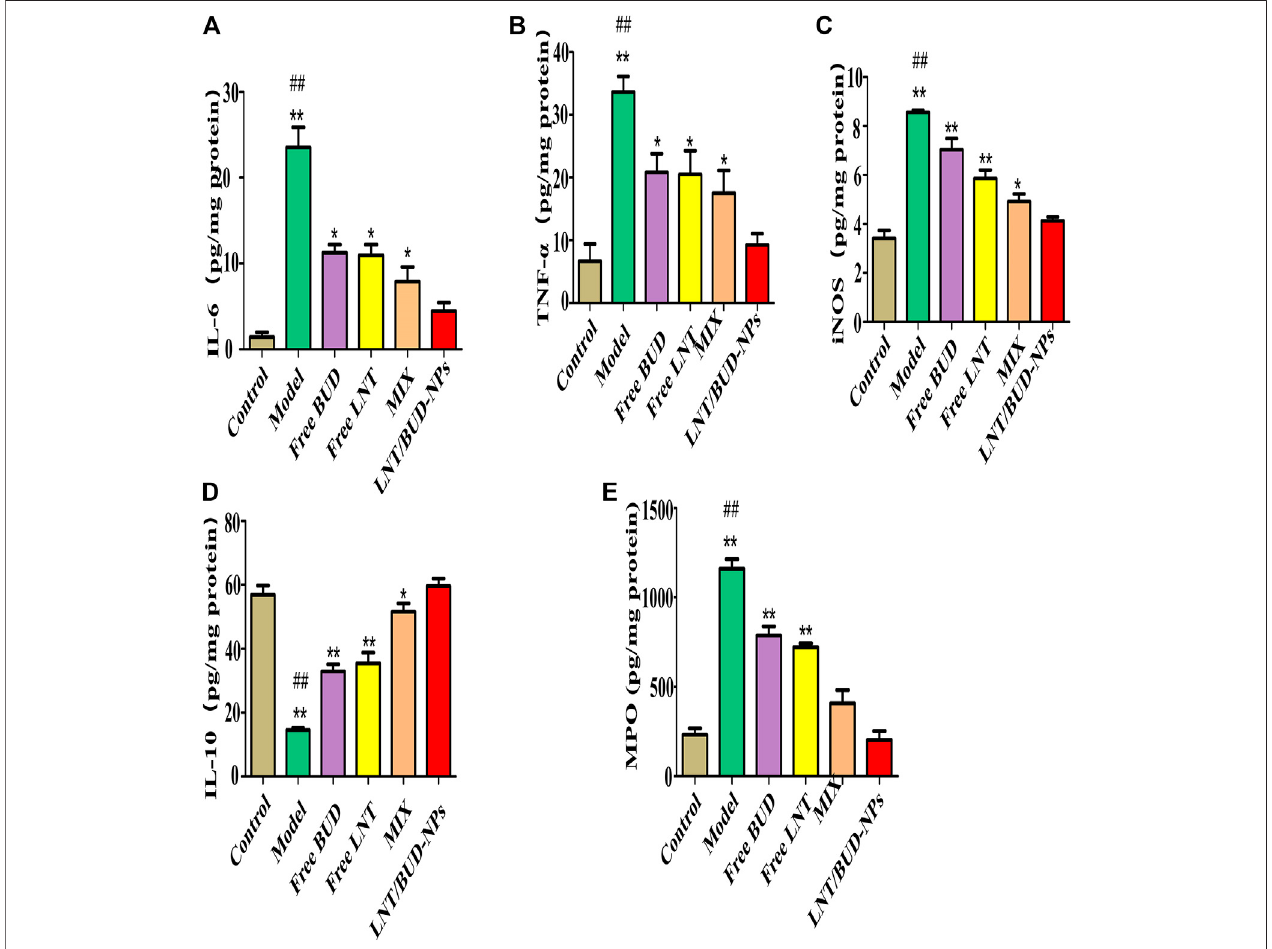
FIGURE 6 | In vivo in fl ammatory cytokine evaluation of DSS-induced UC mice colon from the different formulas. (A – E) Histogram analysis of IL-6, TNF- α , iNOS, IL-10, and MPO level in colon among different formulas. * p < 0.05, ** p < 0.01 vs. LNT/BUD-NPs; # p < 0.05, ## p < 0.01 vs. Model; n (cid:1) 9.